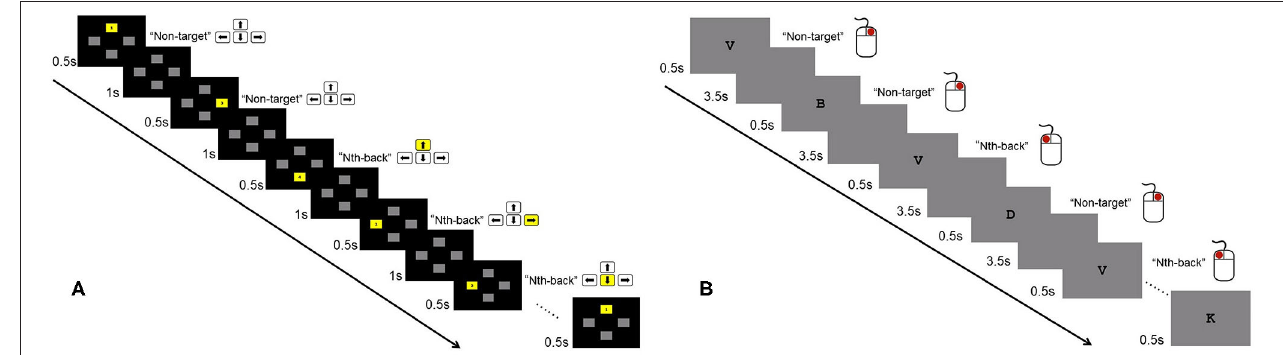
FIGURE 1 | Illustration of the 2-back condition of the visuospatial and verbal N-back tasks. (A) In the visuospatial N-back task, participants were instructed to indicate the location of the previous Nth (1- and 2-back) box that turned yellow using the direction keys of left, right, up, and down. For the 0-back condition, participants pressed the corresponding key as the box turned yellow. (B) In the verbal N-back task, participants pressed the left button if the current letter was the same as the Nth (1-, 2-, and 3-back) letter before; otherwise, they pressed the right button. For the 0-back condition, participants were required to indicate whether the current letter was “X.”